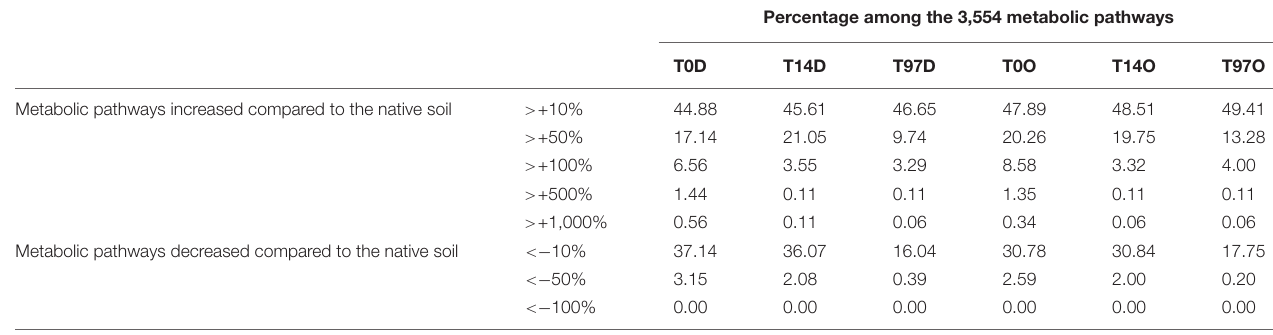
TABLE 2 | Percentage of metabolic pathways (KEGG) increased or decreased compared to the native soil, at T0, T14, and T97.